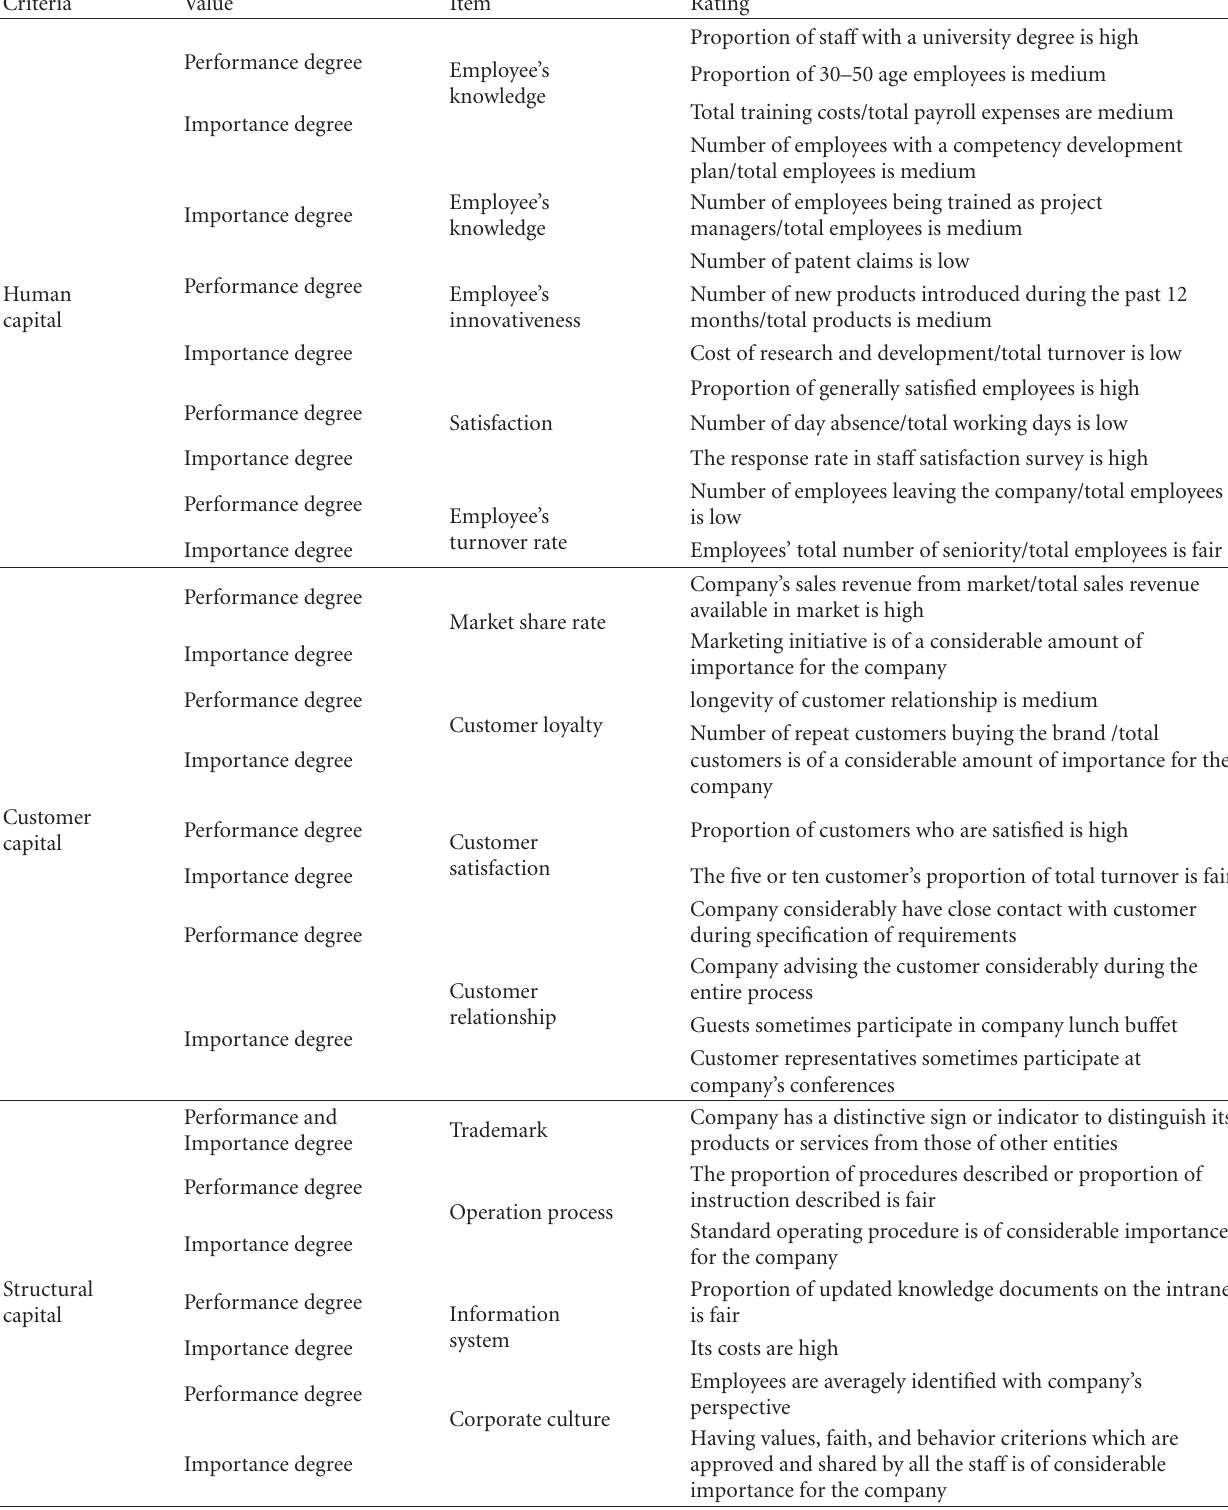
Table 3: Inputs of fuzzy rule-based expert system for sample